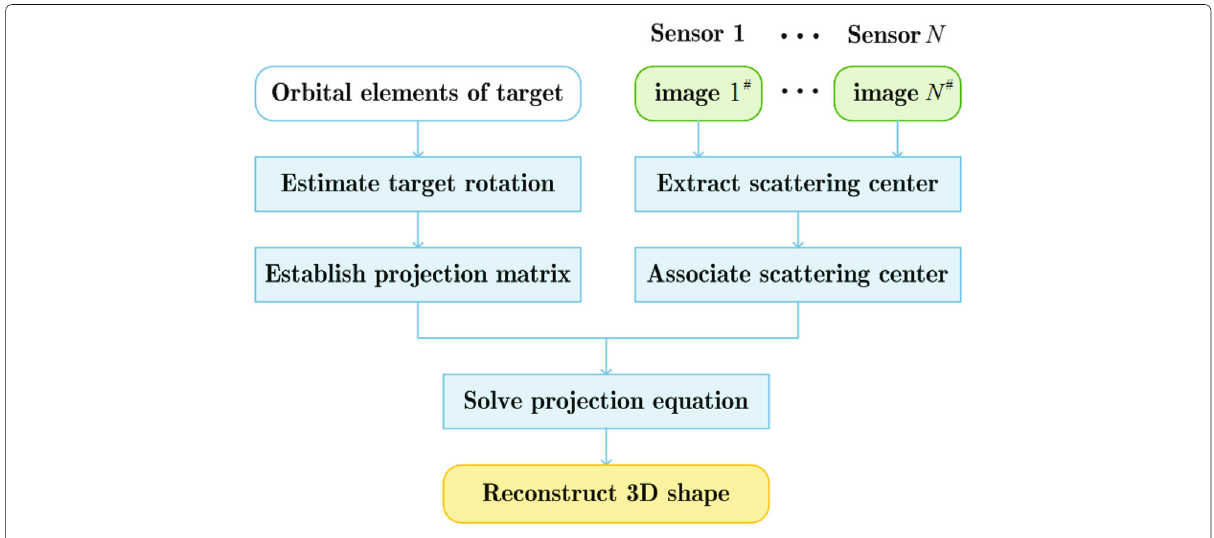
Fig. 2 The block diagram of the algorithm